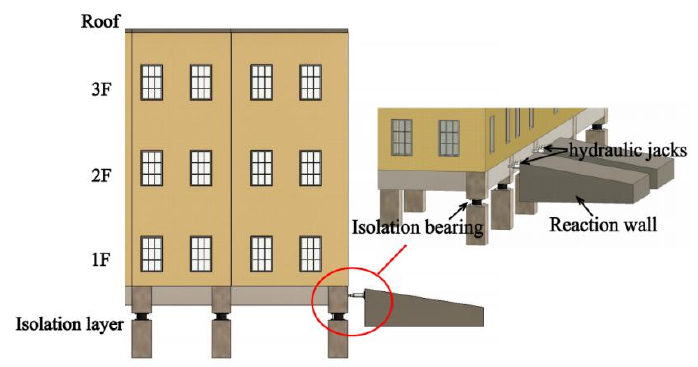
Figure 13. Schematic diagram of initial displacement application.